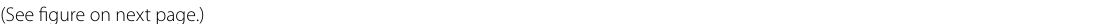
figure on next Fig. 3 Histopathological examination of rat skin from: a group I (No wound) showing the normal histological structure of the epidermis, dermis, subcutaneous tissue and adipose tissue as well as musculature; b group II (Wound, Infection, Untreated) showing focal necrosis and hyalinization were detected in the epidermis, dermis and extended to subcutaneous tissue in association with inflammatory cells infiltration and collagen proliferation; c group III (Wound, Infection, Vehicle) showing focal atrophy in the epidermis while the underlying dermis showed fibrosis. Focal few inflammatory cells infiltration was detected in the subcutaneous tissue; d group IV (Wound, no Infection, Untreated) showing focal fibrosis was detected in the dermis directly underneath the epidermis associated with oedema and few inflammatory cells infiltration in subcutaneous tissue; e group V (Wound, Infection, Treated with Formula 1) showing focal acanthosis in the epidermis accompanied by hyalinization in the underlying dermis as well as musculature. The subcutaneous tissue showed fibrosis with inflammatory cells infiltration and edema; f group VI (Wound, Infection, Treated with Formula 2) showing focal acanthosis in the epidermis while the underlying dermis had fibrosis. The subcutaneous tissue showed inflammatory cells infiltration and focal hemorrhage; g group VII (Wound, Infection, Treated with Formula 3) showing no histopathological alteration in the skin epidermis and dermis while the subcutaneous adipose tissue showed congestion in the blood vessels; h group VIII (Wound, Infection, Treated with Formula 4) showing no histopathological alteration in the skin epidermis, dermis, subcutaneous tissue and